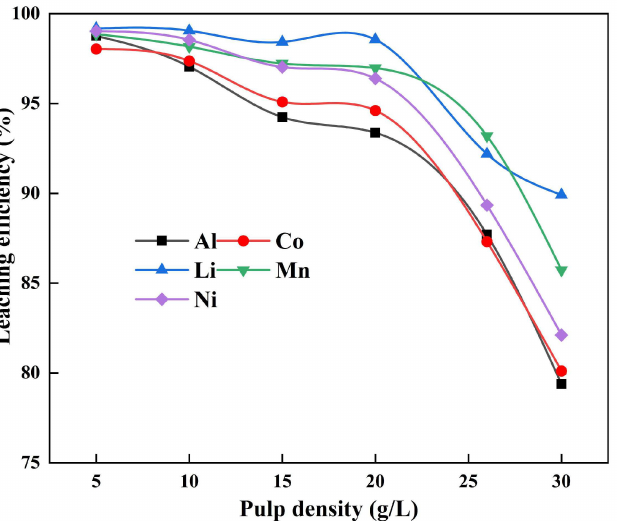
Figure 4. Effect of solid–liquid ratio on the leaching of metals from electrode